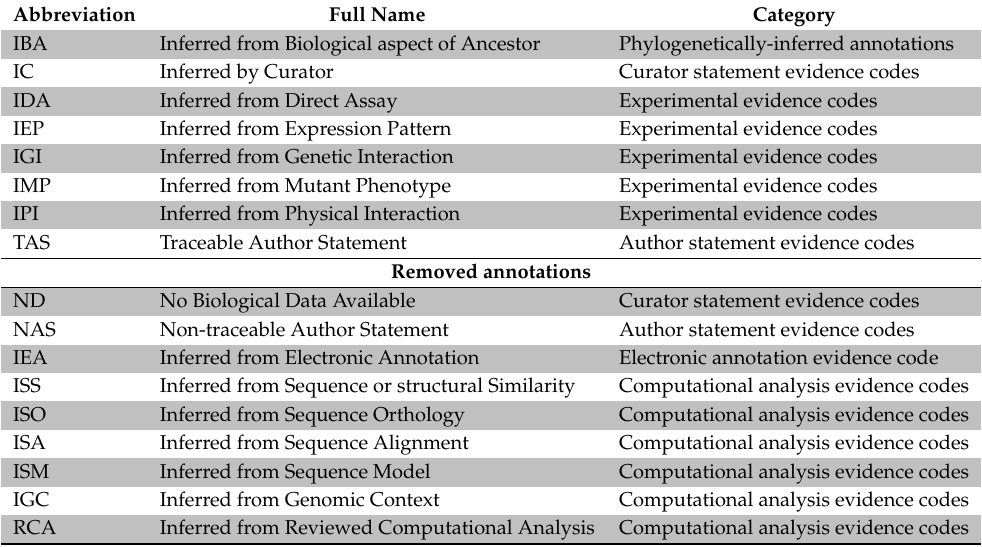
Table A2. List of Gene Ontology (GO) evidence annotation codes that were used to remove genes related to the four GO terms with these annotations (bottom part). Additionally, the annotation codes that were present are shown (top